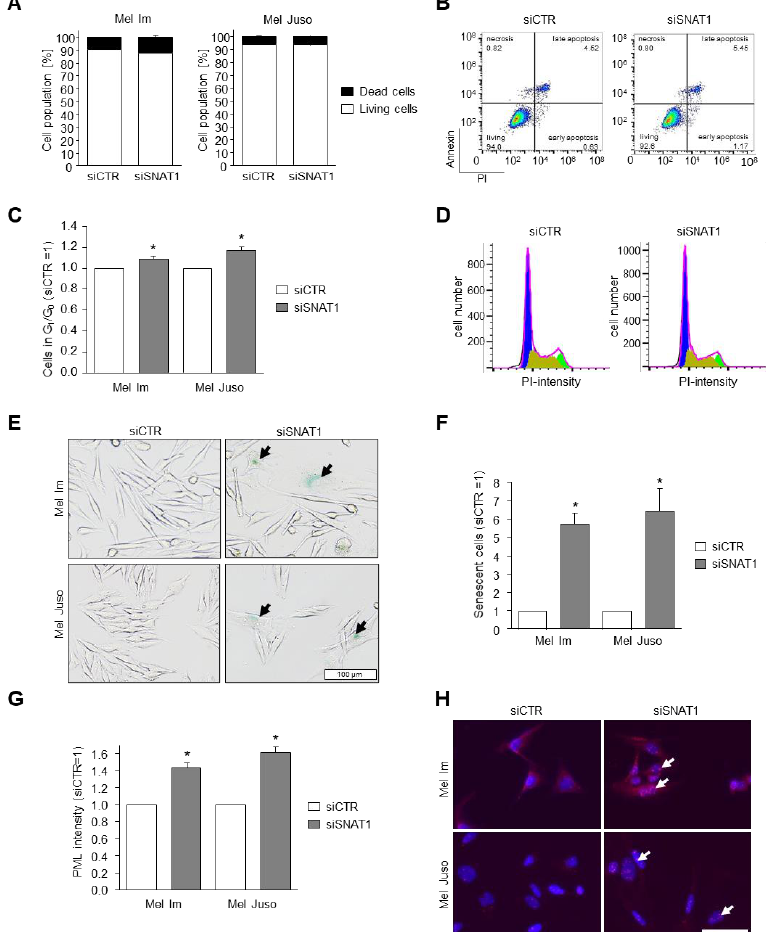
Figure 5. Effects of SNAT1 downregulation on apoptosis, cell cycle progression, and senescence induction. ( A , B ) Analysis of apoptotic and living cells using PI/ annexin-V staining examined with cytometric analysis after siRNA-mediated SNAT1 downregulation, compared to siCTR-transfected melanoma cell lines Mel Im and Mel Juso. Values represent the mean ± SEM of 3 independent experiments. ( B ) Exemplary image of flow cytometry-based apoptosis analysis of cell line Mel Im. ( C , D ) Flow cytometric analysis of cell cycle after siSNAT1 downregulation, compared to siCTR transfected melanoma cell lines Mel Im and Mel Juso. Values represent the mean ± SEM of 3 independent experiments. ( D ) Representative image of cytometric analysis of cell line Mel Juso. G 1 /G 0 -phase in blue, S-phase in olive green, G 2 -phase in light green. ( E ) Exemplary images of light microscopic examination of senescence-associated- β -galactosidase staining of siSNAT1 and siCTR-treated Mel Im and Mel Juso cells. Arrows indicate senescent melanoma cells. ( F ) Quantification of SA- β -galactosidase positive cells (siCTR = 1). Values represent the mean ± SEM of 3 independent experiments. ( G , H ) PML immunofluorescence staining of cell lines Mel Im and Mel Juso after siSNAT1 and siCTR transfection. ( G ) Quantification of PML-immunofluorescence intensity (siCTR = 1). ( H ) Representative image of PML-NB. Panels show overlay of PML (red) and DAPI (blue) staining. Arrows indicate formation of PML-NB. Values represent the mean ± SEM of 3 independent experiments. p -value < 0.05 was considered statistically significant (*).